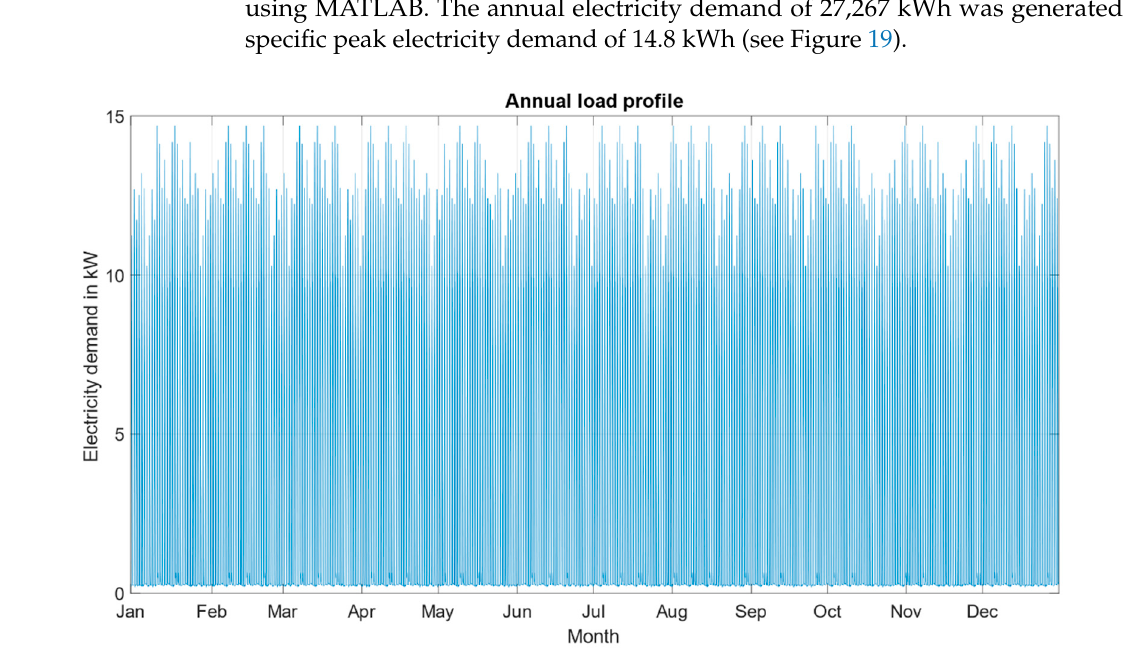
Table 4 . Summary of electric bike measurement results.